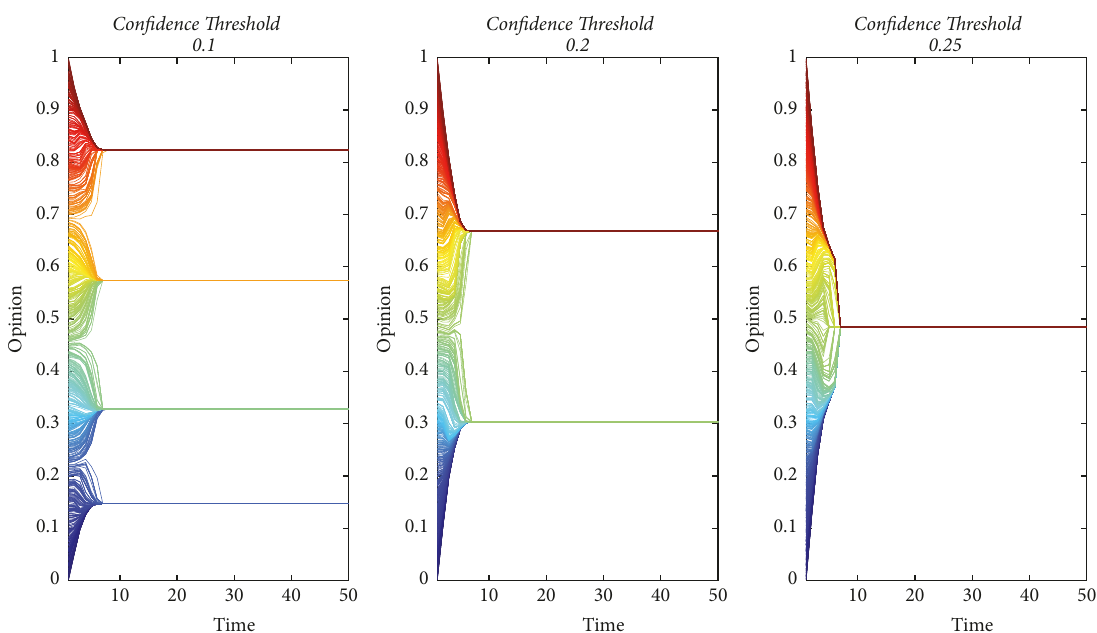
Figure 2: Opinion evolution results for the HK model with different confidence thresholds.